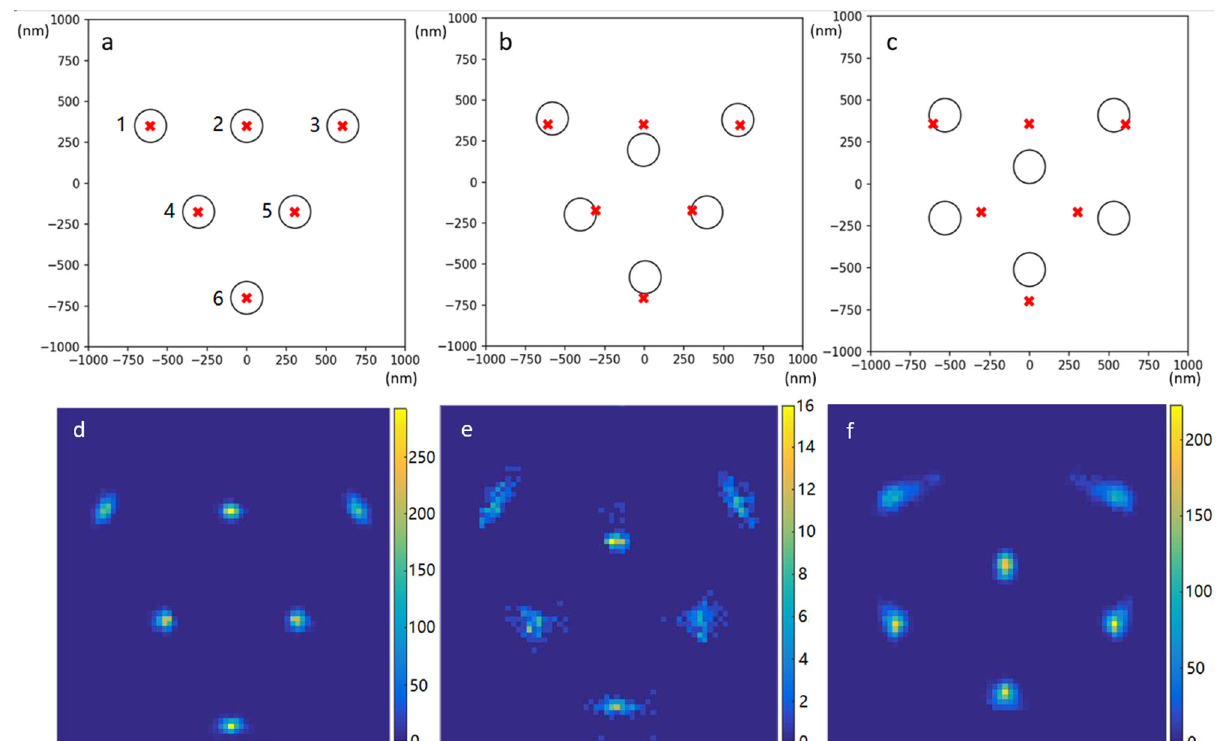
Fig. 2 Particle positions and collective dynamics over the course of a triangle-to-chevron con fi gurational isomerization. a – c Mean deviations of particle position(s) (black circles) from the triangle con fi guration (red crosses) to the chevron con fi guration obtained over the course of a representative transition. d – f Empirical probability densities of particle positions compiled from 21,186 con fi gurations at an optical power of 70 mW. The color scheme describes the number of con fi gurations that contains a particle centered at a speci fi c pixel. Con fi gurations are binned into 22 windows of 20 nm in the distance between particles “ 2 ” and “ 6 ” (see panel a ) and empirical probability density functions estimated by histogramming all con fi gurations in each bin under a rotational and translational alignment to the mean particle positions (red crosses). The position probability density plots associated with a – c are presented in panels d – f ,